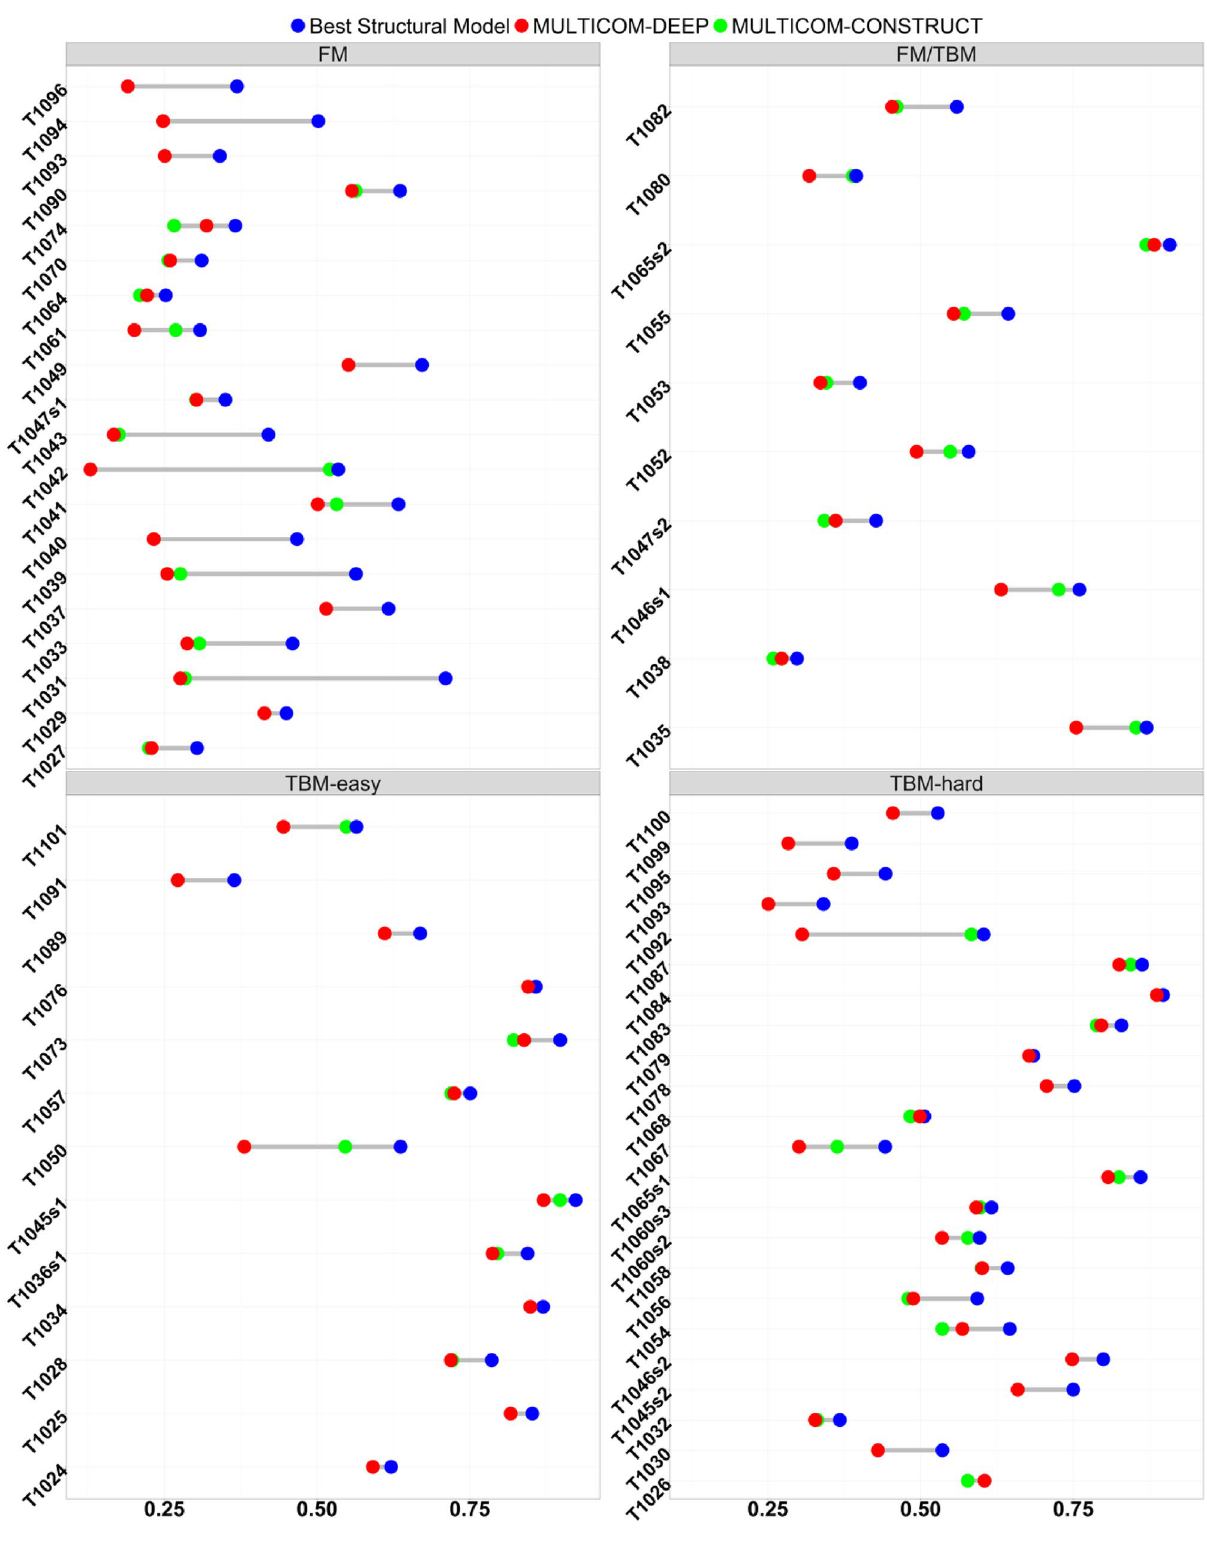
Figure 5. The GDT-TS score of the best structural model (blue dots) for a target, the top model selected by MULTICOM-CONSTRUCT (green dots), and the top model selected by MULTICOM-DEEP (red dots). Closer to a blue dot, lower the loss of the top model represented by a green/blue dot. If a green/blue red dot overlaps with a blue dot, the GDT-TS loss is